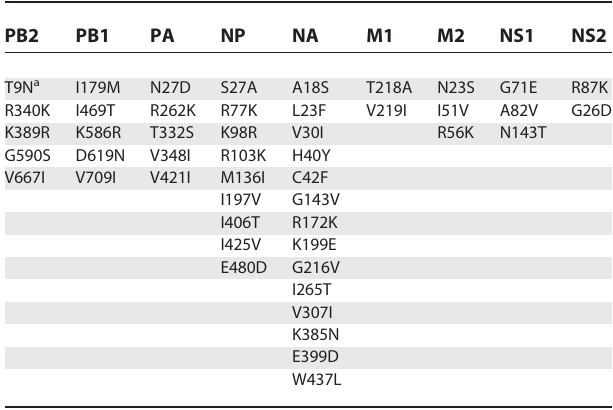
Table 1. Amino Acid Changes Between the Proteins Encoded by the Clade A and Clade B